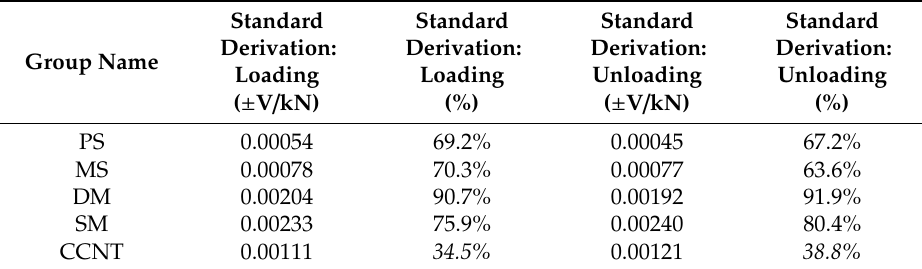
Table 4. Comparisons of consistency / repeatability.